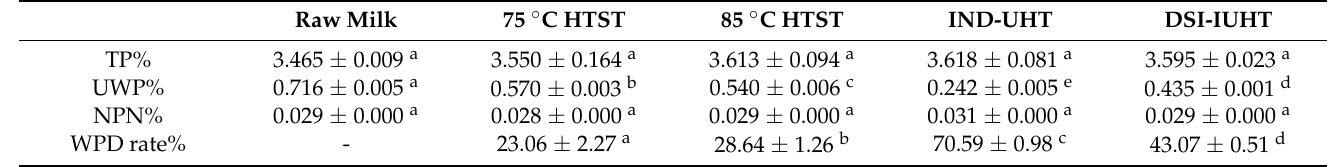
Table 1. Percentages of the total protein (TP), undenatured whey protein (UWP), non-protein nitrogen (NPN), and whey protein denaturation (WPD) rate for raw milk and the different heat-treated milk samples.